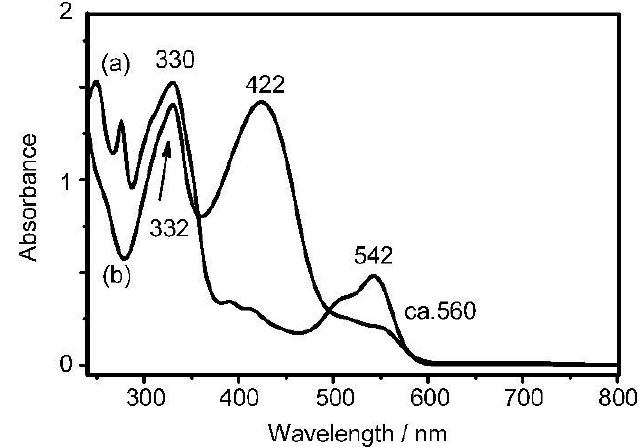
Figure 4. UV-Vis spectra of ( a ) monomer 2 and ( b ) P(BOCI-Flu) in